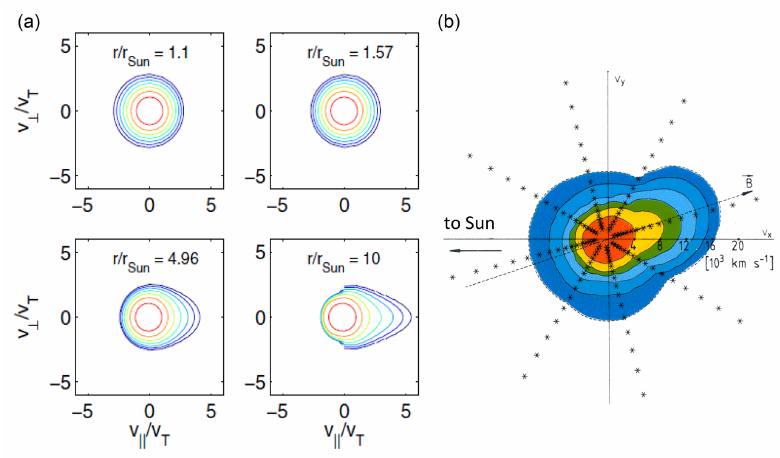
Figure 9. (a) Four numerically calculated electron velocity distribution functions (Smith et al., 2012) for different distances from the solar surface. (b) Typical measured (by Helios beyond 0.3AU) electron distribution function (Pillip et al., 1987a) revealing a strong field-aligned distortion of its shape, the so-called strahl. Colored isocontours are spaced at levels that differ by a factor of them, with a reference level of unity at the maximum. Asterisks in the right frame indicate the measurement